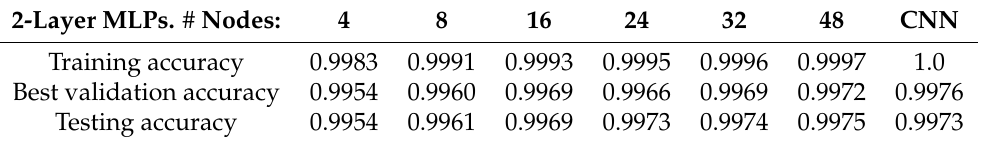
Table 1. Mean accuracies observed during the training stage of the CNN (the last column) and 2-layer MLPs with different number of nodes in each of the hidden layers (4, 8, ..., 48). 2-Layer MLPs. #